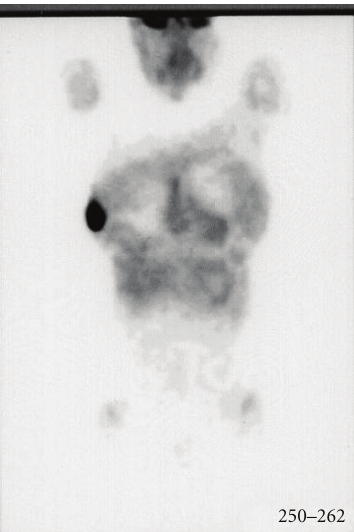
Figure 1: FDG-PET: positive uptake of radiotracer in the right breast.